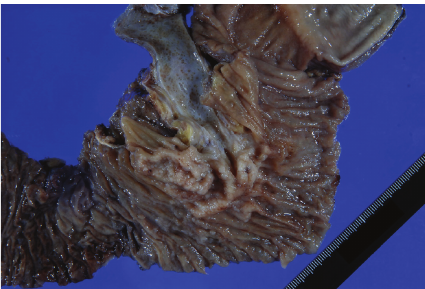
Figure 3: Macroscopic findings of the tumor. The tumor of the ampulla of Vater forms a mass with ulceration and multiple small nodular lesions are found around it.